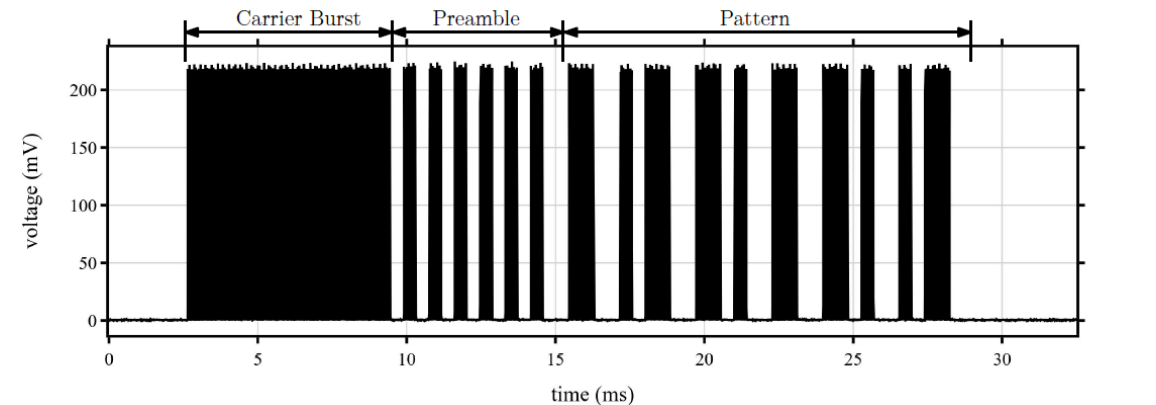
Figure 4. Manchester-coded wake-up signal consisting of carrier burst, preamble, and address pattern [34].